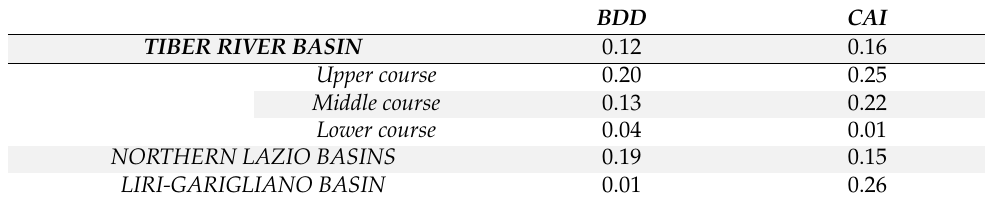
Table 6. DDTW of BDD and CAI